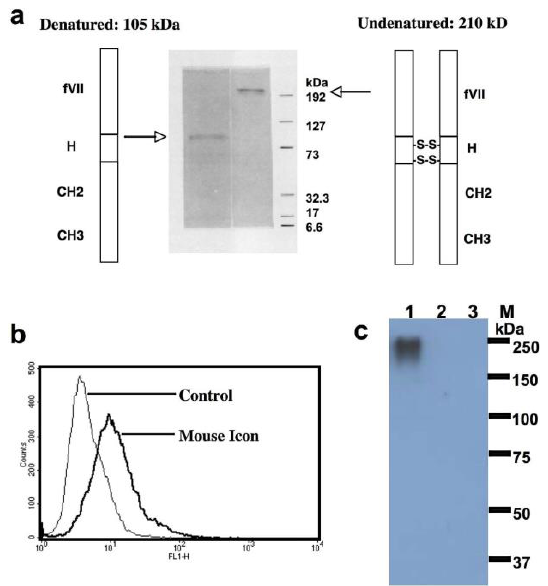
Figure 4. Diagram and characterization of the first generation TF-targeting immunoconjugate (ICON) protein. ( a ) Molecular weight of the ICON protein produced by Chinese Hamster Ovary (CHO) cells analyzed by SDSPAGE. fVII: mouse factor VII with K341A mutation; H: hinge region of a human IgG1 Fc; CH2 and CH3: the second and third domains of the constant region on the heavy chain of a human IgG1 Fc. ( b ) Binding activity of ICON protein to human tongue cancer TCA8113 cells by flow cytometry. Control: TCA8113 cancer cells were not incubated with ICON but with secondary antibody FITC. Mouse ICON: the cells were incubated with ICON protein then with the secondary antibody to human IgG Fc FITC. ( c ) Immunoprecipitation Western-blotting analysis of ICON protein production by TCA8113 cells one day after infection with AdmICON (lane 1) or AdBlank (lane 2). The serum free culture medium from uninfected TCA8113 cells was used as an uninfected control (lane 3). M: Protein markers (Bio-Rad). Molecular weights (kDa) of the protein markers are indicated. Modified from ref [84].